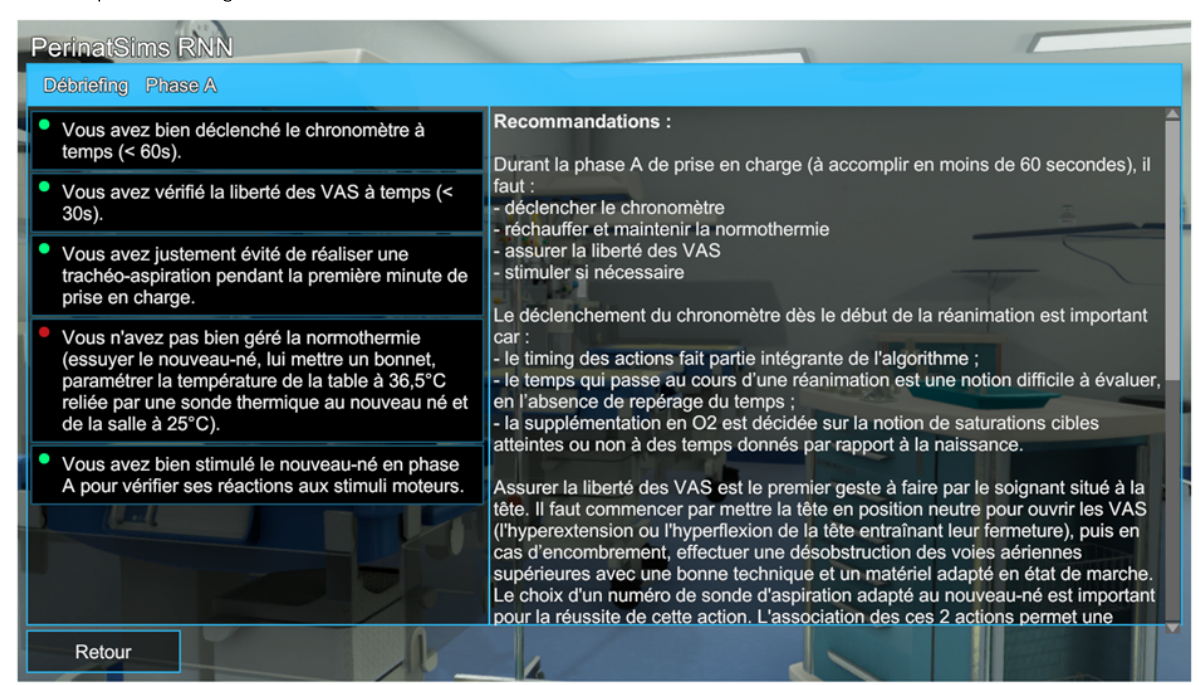
Figure 3. Computer debriefing of technical skills.